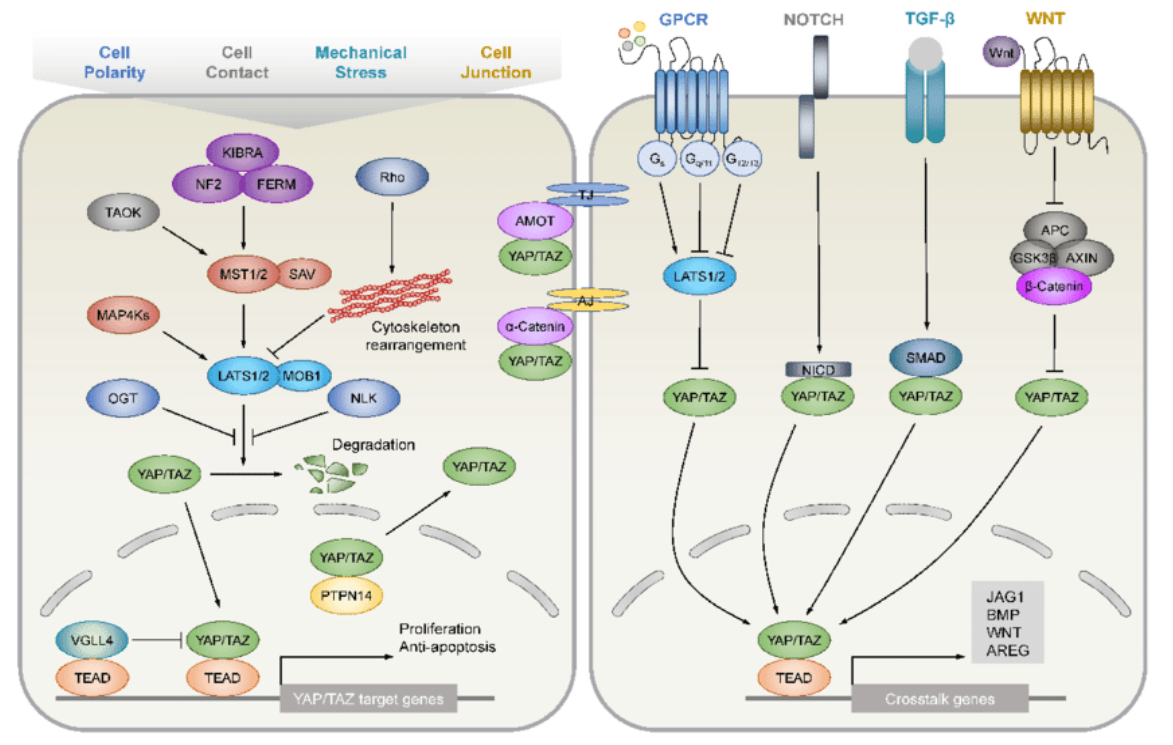
Figure 5. Hippo pathway and its crosstalk with other signalling pathways. Figure replicated from [65] under Creative Commons license, provided at https://creativecommons.org/licenses/by-nc/4.0/ (accessed on 29 January 2023). Changes have been made to the figure legend .